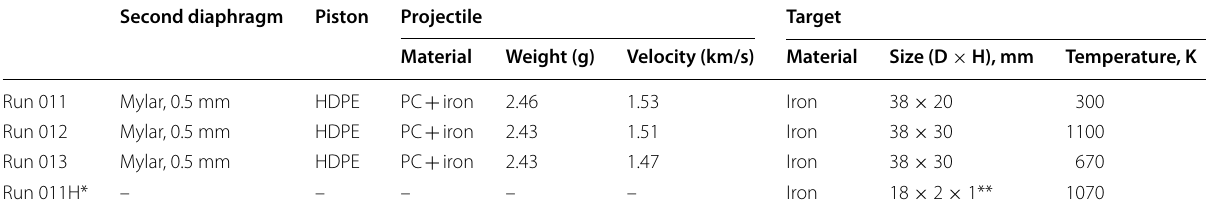
HDPE, High-Density Polyethylene: PC, Polycarbonate *annealing experiment, **Height